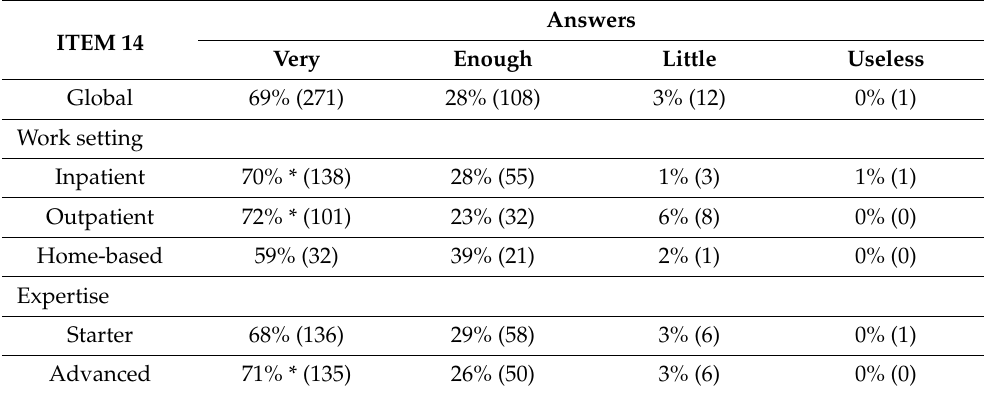
Table 3. Answers referred to item 14: How much do you think the multidisciplinary team can pos ‐